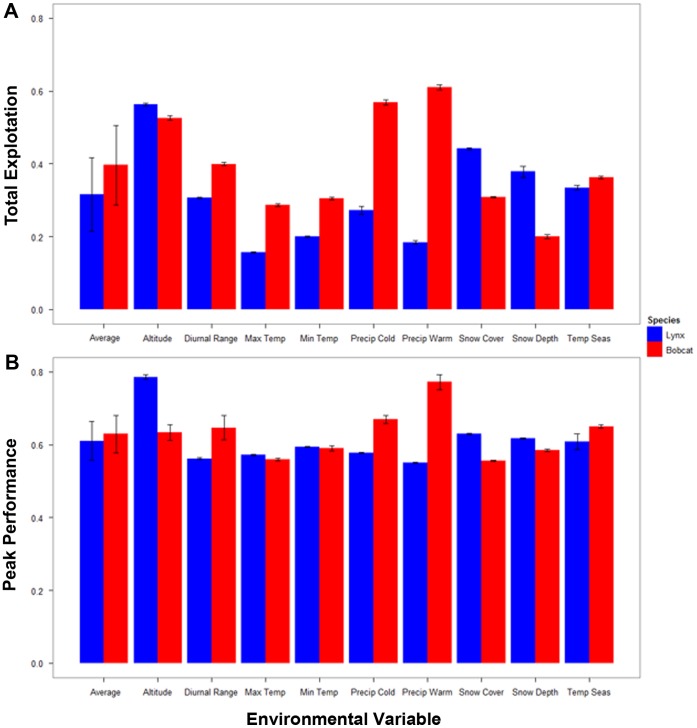
Area under the curve and peak performances of both species over each environmental variable.A) Represents the average area under the curve value for Canada lynx (blue) and bobcat (red) for the response curves for each environmental variable. B) The average peak performance value for Canada lynx (blue) and bobcat (red) for the same response curves. Confidence intervals (95% CI) that are large enough to be displayed are visible on the graph.